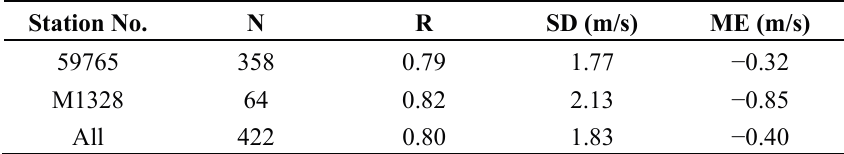
Table 6. The same as Table 5, but for